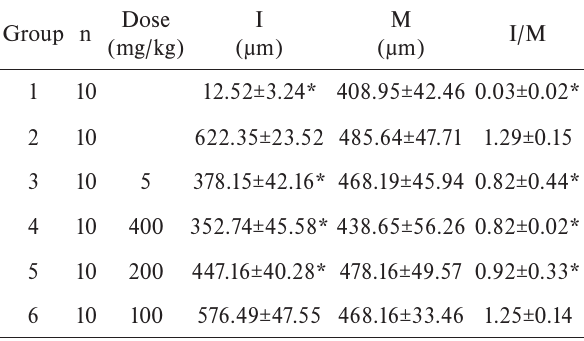
Table 4. Effects of puerarin on pathomorphology (x ± s).